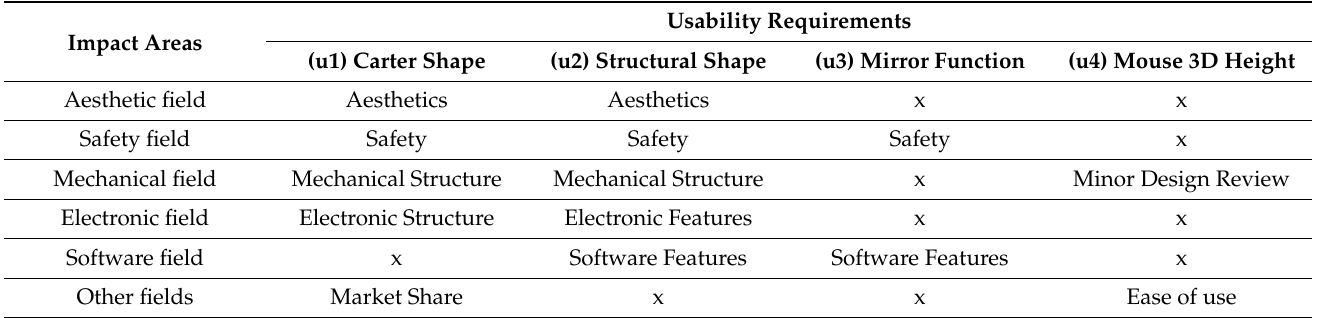
Table 7. Overview of fields affected by usability requirements that emerged in the illustrative